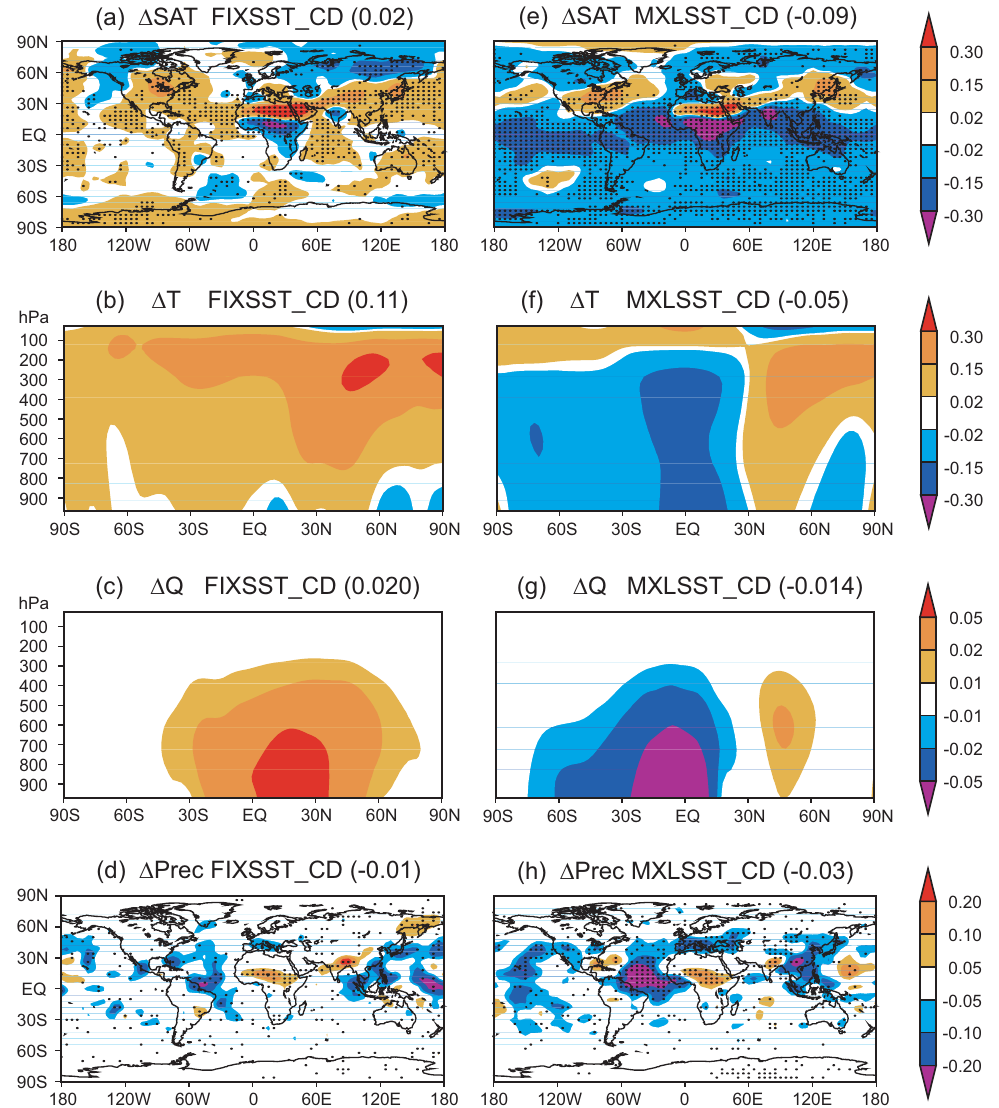
Fig. 7. Same as Fig. 4 but for dust-induced changes in meteorological fields with fixed SST and dust-climate coupling (FIXSST CD – FIXSST CTRL, left panels) and with the mixed-layer ocean and dust-climate coupling (MXLSST CD – MXLSST CTRL, right panels).